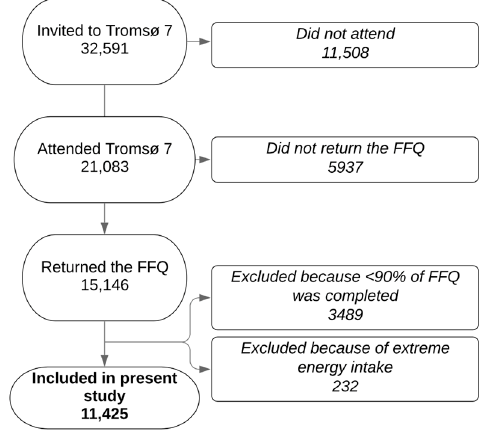
Figure 1. Flowchart of study sample. FFQ: food frequency